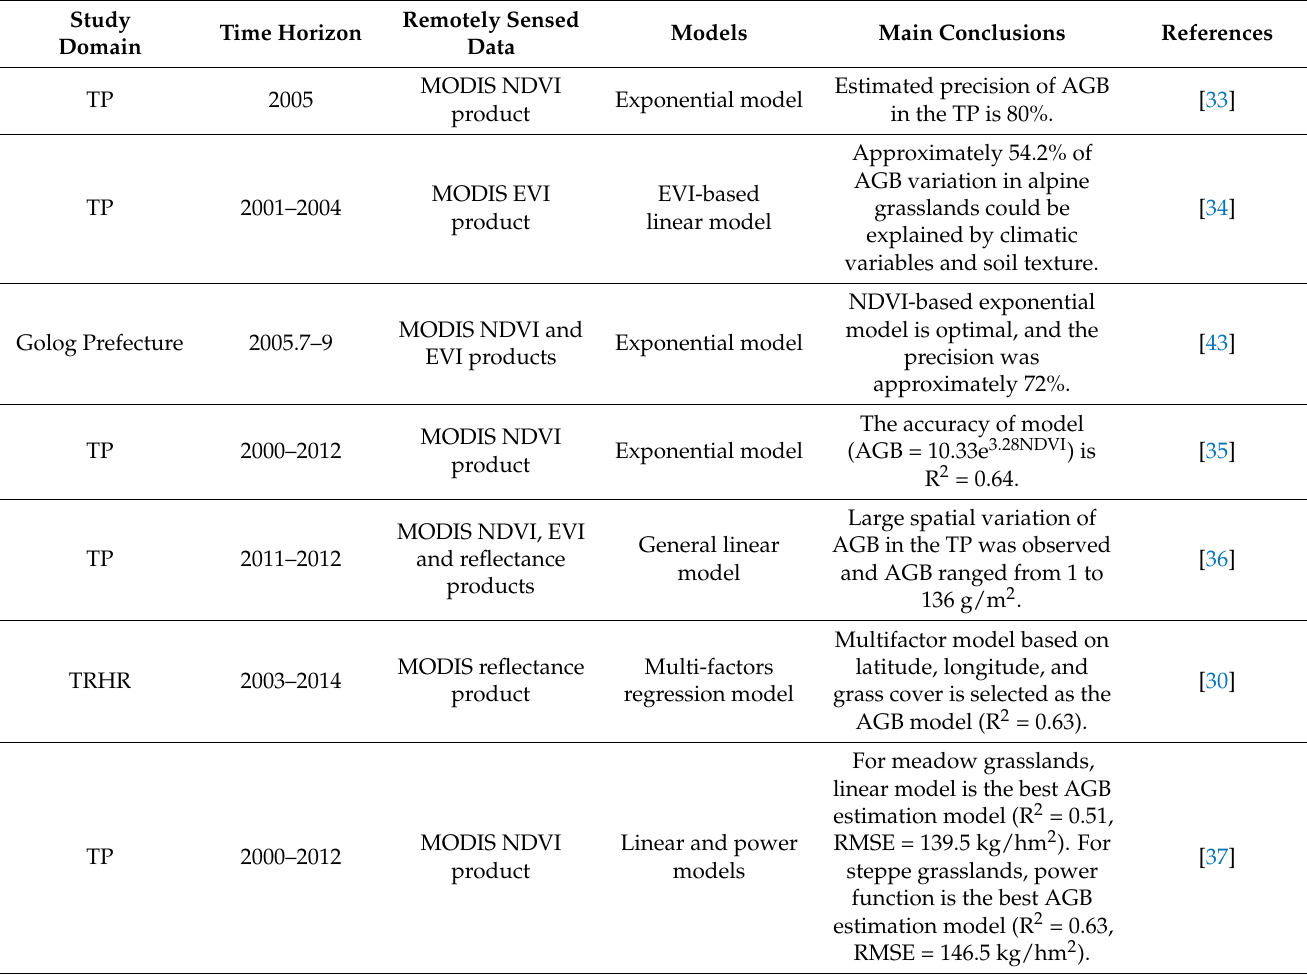
Table 1. Summary of relevant studies on estimating grassland AGB based on MODIS products in regions relative to TRHR or TP. Study